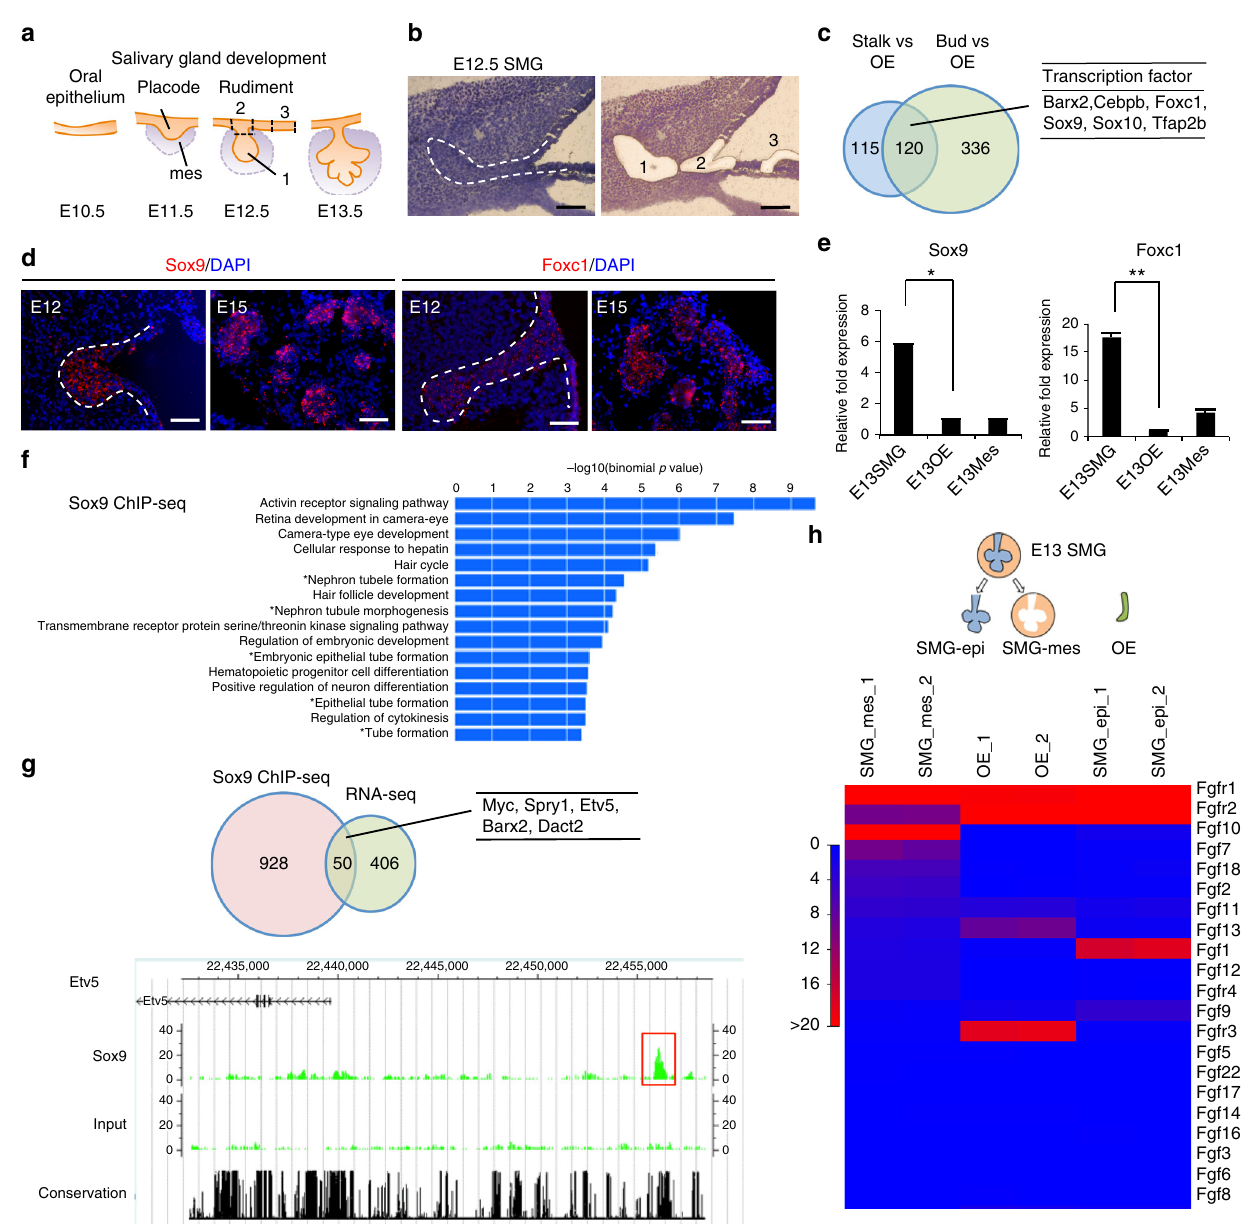
Fig. 1 Identi fi cation of essential factors related to salivary gland development. a Schematic representation of salivary gland development. b Representative images of submandibular gland (SMG) bud (1), SMG stalk (2), and oral epithelium (OE) distant from SMG (3) before and after laser micro-dissection. The white dashed line indicates SMG epithelium. Scale bars, 50 μ m. c Venn diagram illustrating the overlapping genes between the genes up-regulated in stalk and bud compared with OE. Up-regulated genes were selected by identifying genes showing fold changes greater than 2.0 and RPKM values higher than 5.0 in stalk and bud. List of common up-regulated transcription factors in stalk and bud. d Sox9 and Foxc1 gene expressions were detected in E12.5 and E15.5 SMG by single-copy RNA FISH. The white dashed lines indicate SMG epithelium. Representative images from one out of three embryos are shown. Scale bars, 50 μ m e Real-time RT-PCR analysis of Sox9 and Foxc1 in the SMG epithelium (SMG-epi), SMG mesenchyme (SMG-mes), and oral epithelium (OE) distant from SMG at E13.5. The results are presented as the mean ± S.D. of triplicate samples and were normalized to GAPDH. Statistical analyses were performed using Student ’ s t -test; * P = 0.0003, ** P = 0.00007. This experiment was replicated three times with similar results. f GREAT gene ontology (GO) analysis of Sox9 ChIP-seq results from E13.5 SMGs. g Venn diagram illustrating the overlap between the up-regulated genes in E12.5 SMG bud compared with OE in RNA-seq analysis and the neighbor genes of the Sox9 peaks identi fi ed from Sox9 ChIP-seq analysis (left). List of overlapping genes involved in salivary gland development (right). CisGenome browser view of Sox9 peaks (red square outline) around the Etv5 region is also shown. Sox9 ChIP-seq (top), an input control (middle), and a conserved region (bottom). The highlighted red box indicates a Sox9 peak region. h RNA-seq analysis of the epithelium and mesenchyme of the E13.5 SMG and the OE. Heat map depicting the expression data. Only FGF signalling-related genes are listed